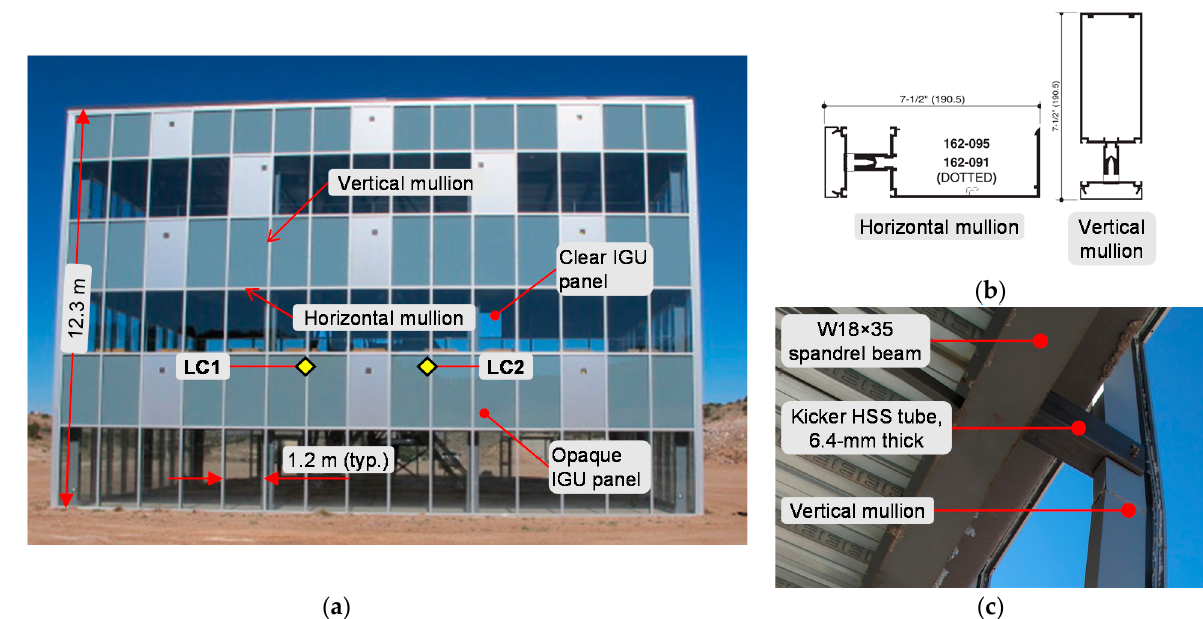
Figure 4. View of the test structure with conventional curtainwall glazed façade used for Test 1: ( a ) South elevation view (LC = load cell, refer to Figure 9a); ( b ) Horizontal and vertical mullion cross-sections; ( c ) Vertical mullion-to-spandrel beam connection with kickers.